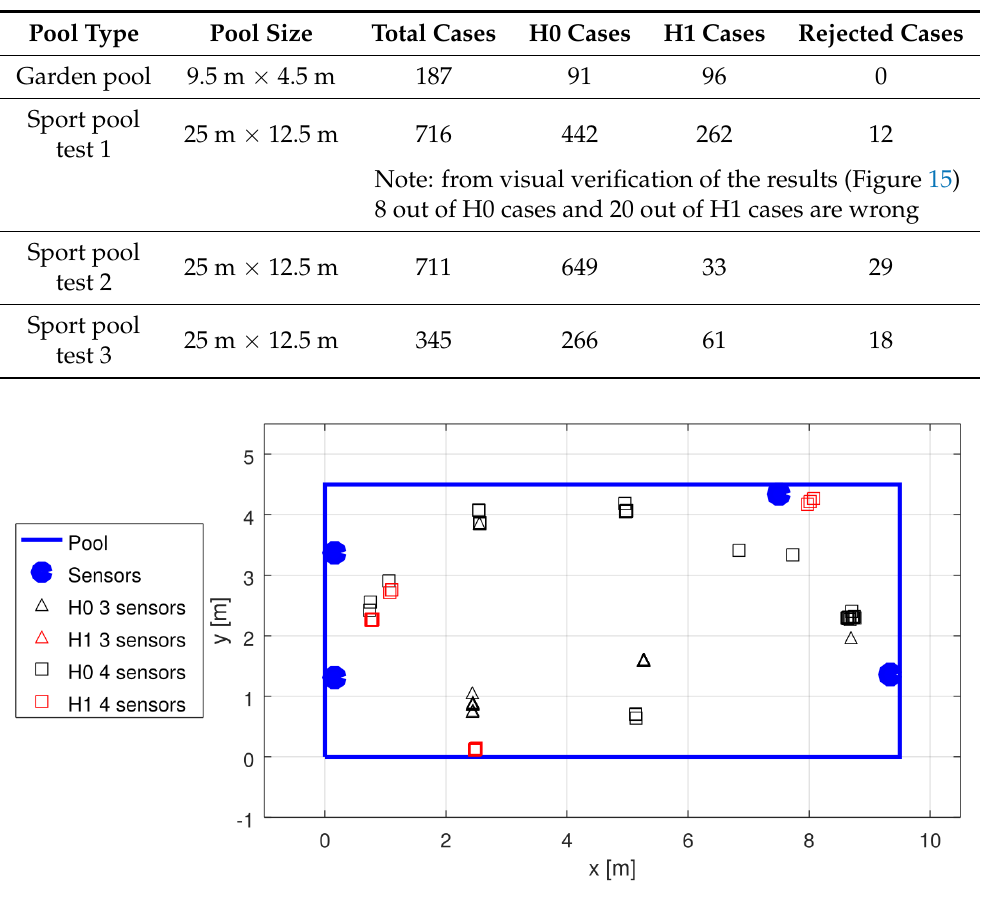
Figure 14. Localization results in garden pool tests.